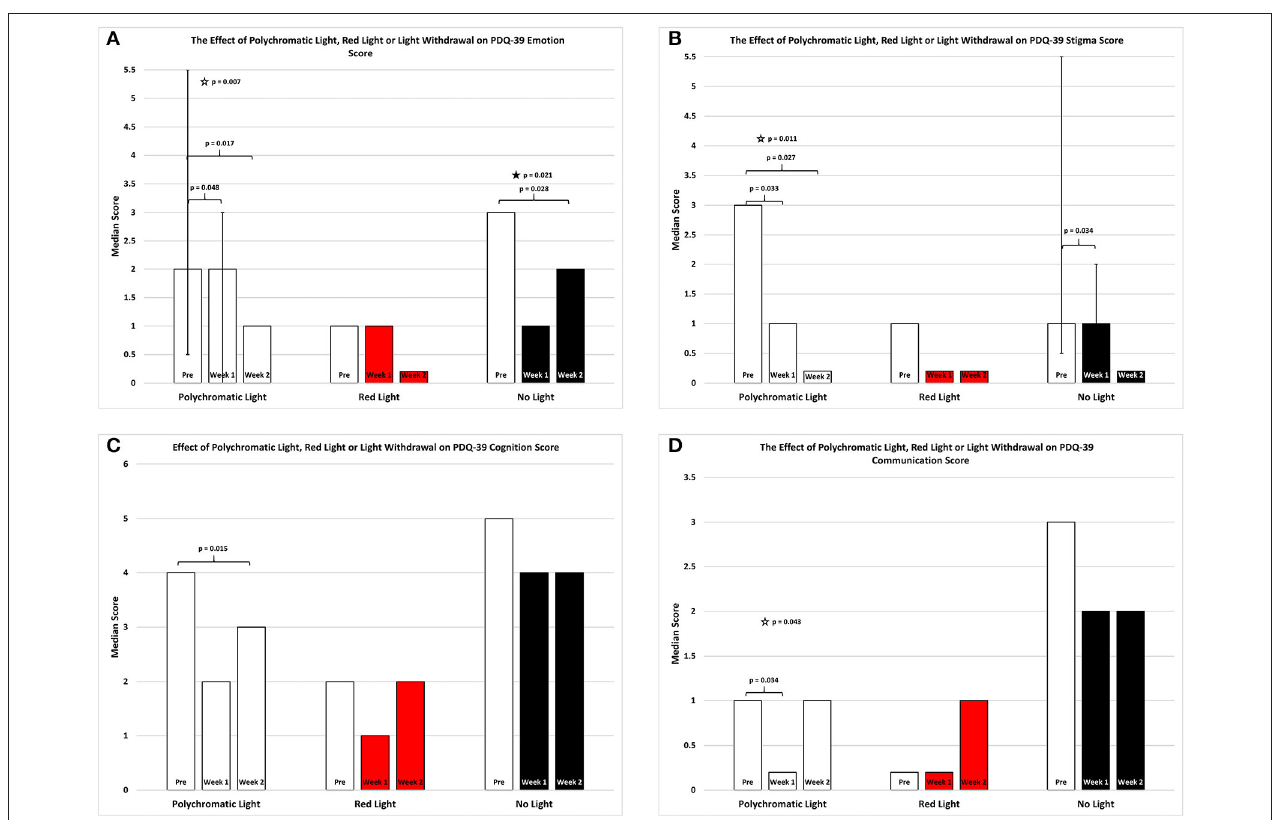
FIGURE 3 | The effect of continued daily exposure to polychromatic light, red light or withdrawal of polychromatic light on the Emotion (A) , Stigma (B) , Cognition (C), and Communication (D) sub-sections of the PDQ-39 is expressed as the median score for each group after 3 assessments over a 2 week period. The pre-score served as the baseline and was obtained when the study commenced and before patients were randomly assigned to their respective treatment groups. The inclusion bars show significant statistical comparisons with p -values indicating the levels of significance obtained. Statistical comparisons were made between baseline (Pre) and Week 1, Pre and Week 2 and Week 1 and Week 2. Significant levels were determined a priori with a significant effect defined as p ≤ 0.05 while trends were designated as p values ranging from 0.051 to 0.099. The star represents a significant overall effect using the Friedman’s Two Way ANOVA while the inclusion bars mark significant comparisons using the Wilcoxon Signed Rank Test. The T-bars represent first quartile and third quartile values. This provides a reference point whereby the range of values around the median serves to assist in visualizing the direction of change between medians in instances where median values were equal but significantly